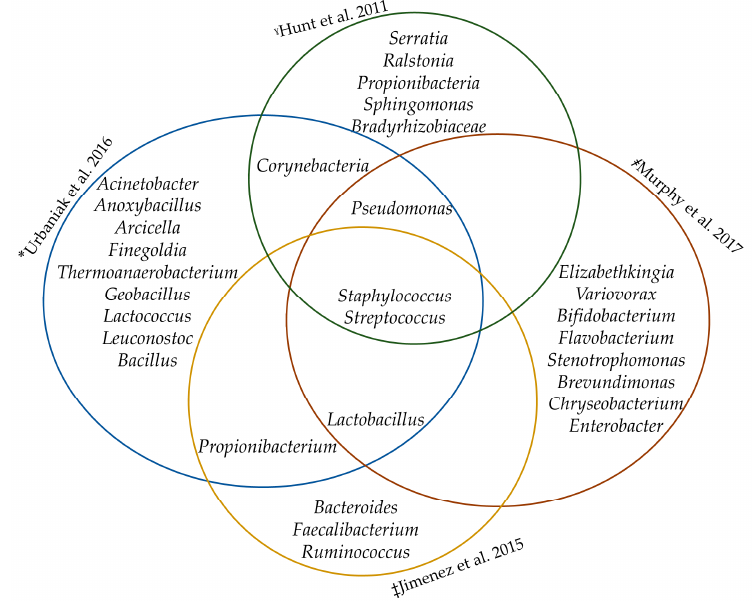
Figure 1. The core human breast milk bacteriome. *QIAamp ® DNA Stool Kit (Qiagen), V6 region of bacterial 16S rRNA gene, Ion Torrent platform. ˠ QIAmp DNA Stool Mini Kit (Qiagen), V3–V4 region of bacterial 16S rRNA gene, Illumina MiSeq platform. ‡QIAamp DNA Mini Kit (Qiagen) with previous mechanical and enzymatic lysis, V1–V2 region, Pyrosequencing.